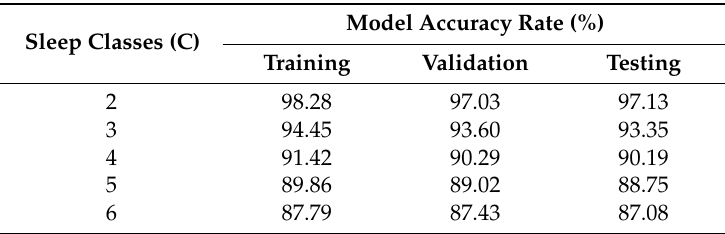
Table 9. Performance values for the sleep-edfx data of the models featuring two to six classes using single-channel EOG.